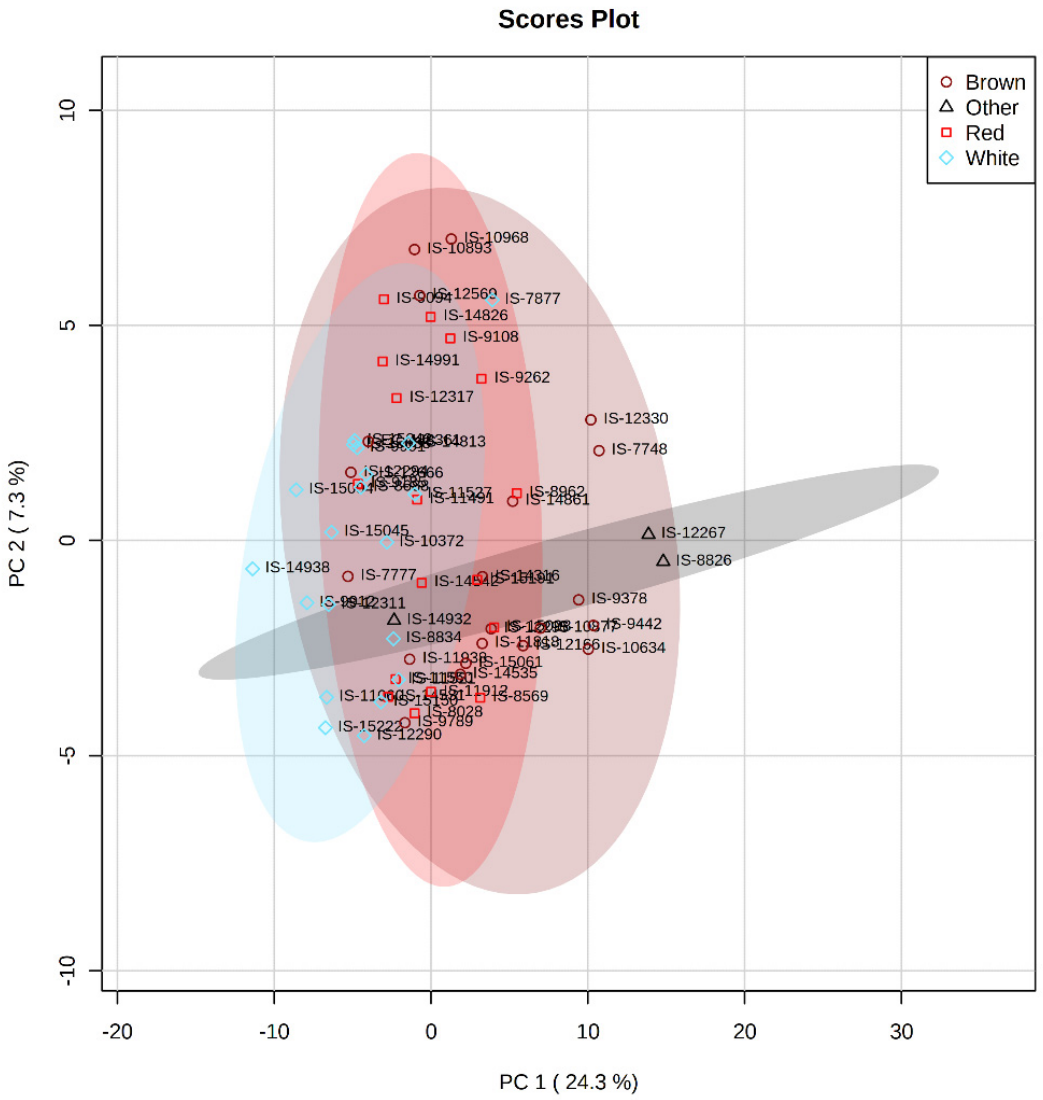
Figure 7. Genetic variation for accumulation of metabolites among diverse sorghum accessions obtained through principal component analysis.